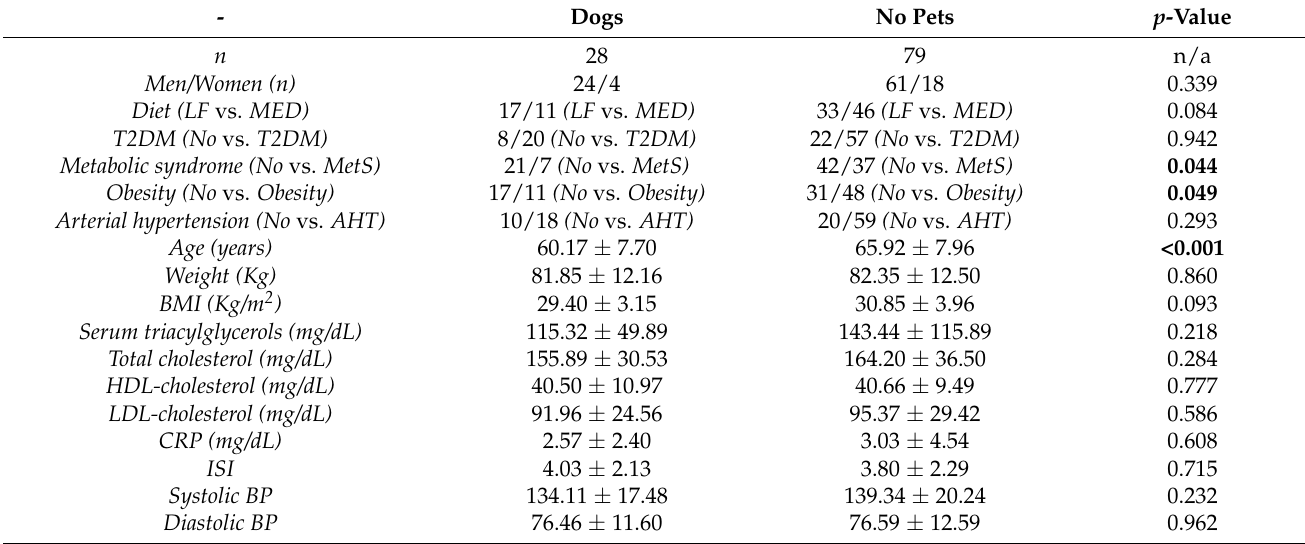
Table 2. Differences between dog-owners and non-pet owners. Values correspond to the mean ±